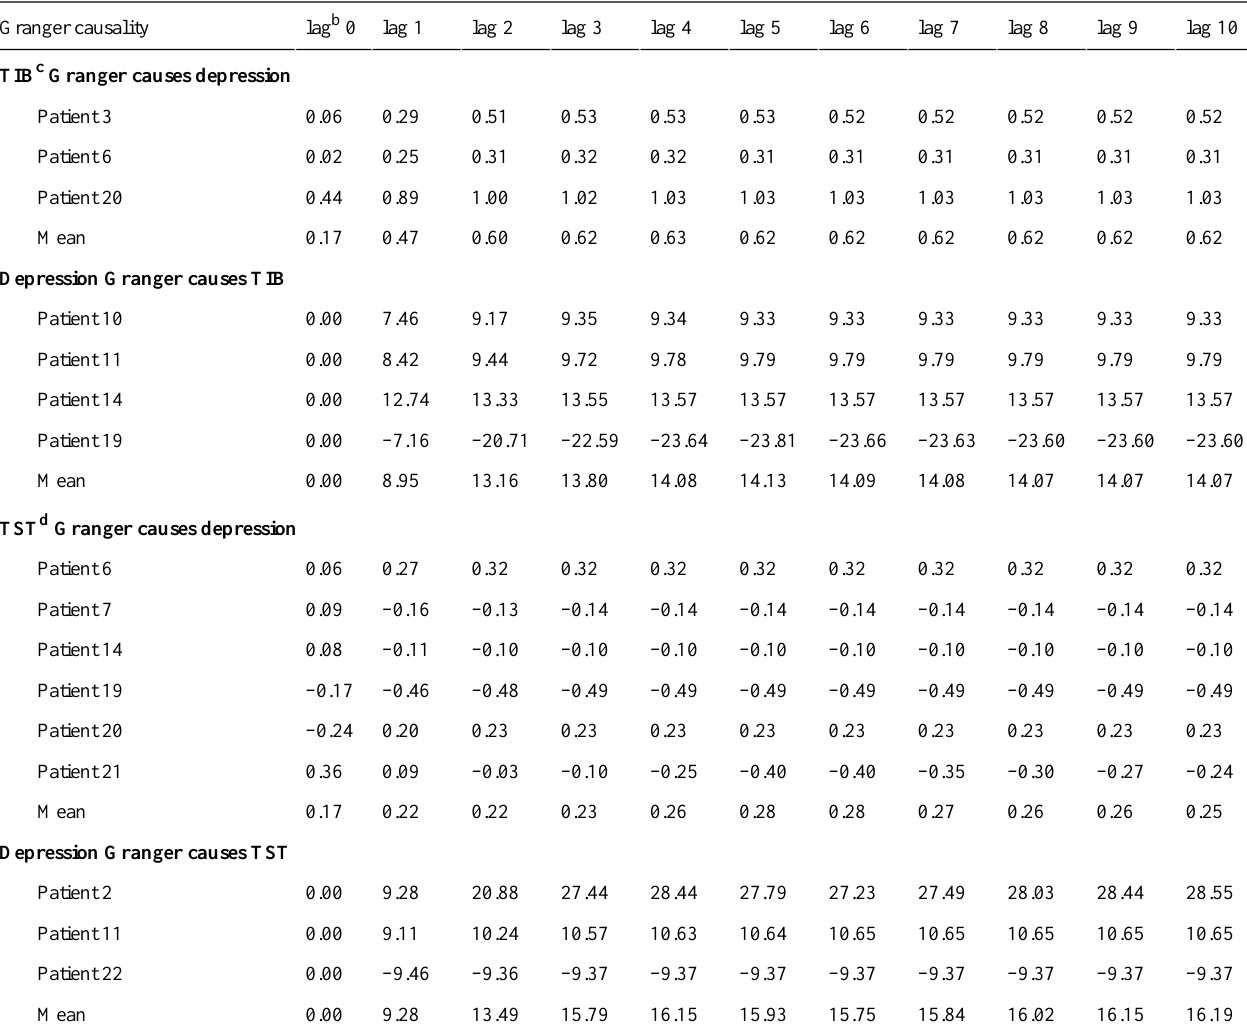
Table 3. Cumulative results a of impulse response analysis for all patients with significant Granger causality test